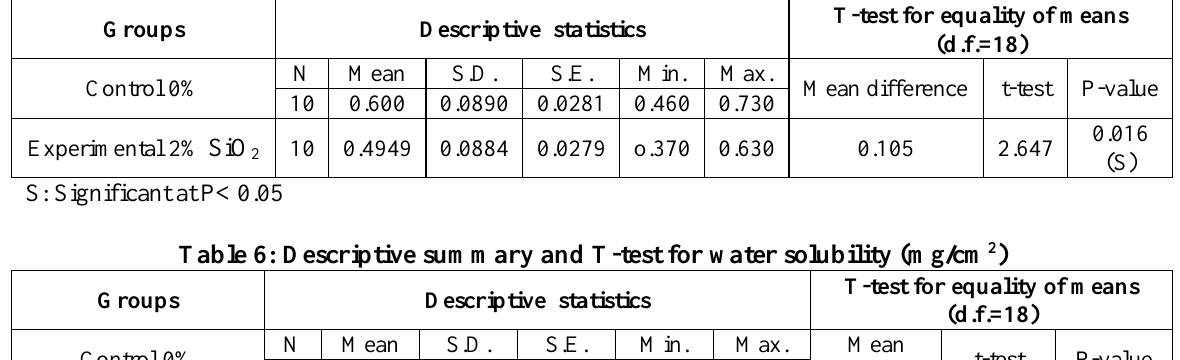
T-test for equality of means (d.f.=18)